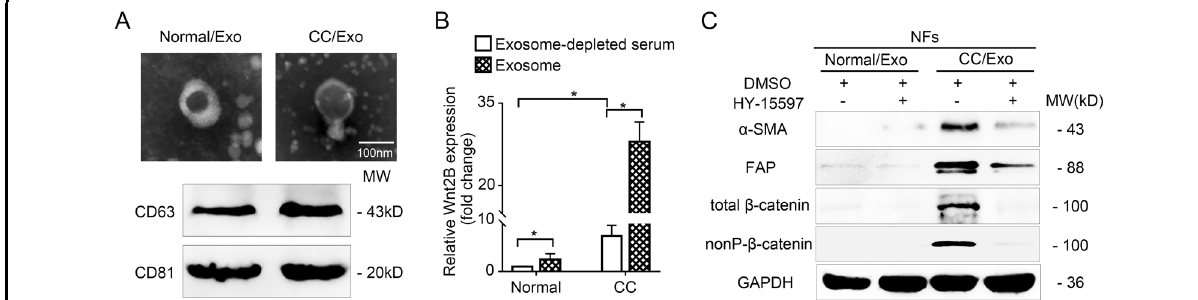
Fig. 6 Circulating exosomal Wnt2B is associated with fi broblasts acquiring an activated phenotype. A Morphology of serum exosomes con fi rmed using transmission electron microscopy. Scale bar, 100 nm. Western blot analysis for exosomal markers (CD63 and CD81). B ELISA analysis for Wnt2B levels in circulating exosomes from healthy individuals ( n = 4) and patients with CC ( n = 8). C Western blot analysis for α -SMA, FAP, and total and nonP- β -catenin (Ser33/37/Thr41) in NFs treated with DMSO or HY-15597 before treatment with the two groups of exosomes. GAPDH was used as the loading control. Error bars represent the mean ± SD of three independent experiments. * P <